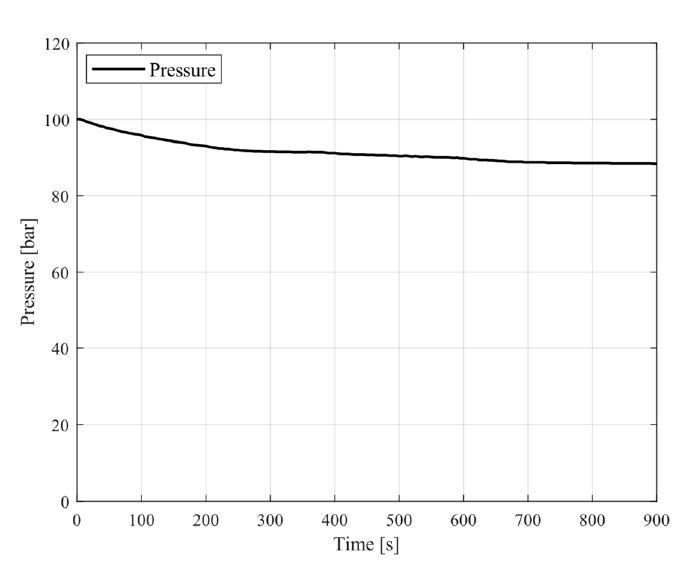
Figure 5. Pressure profiles.